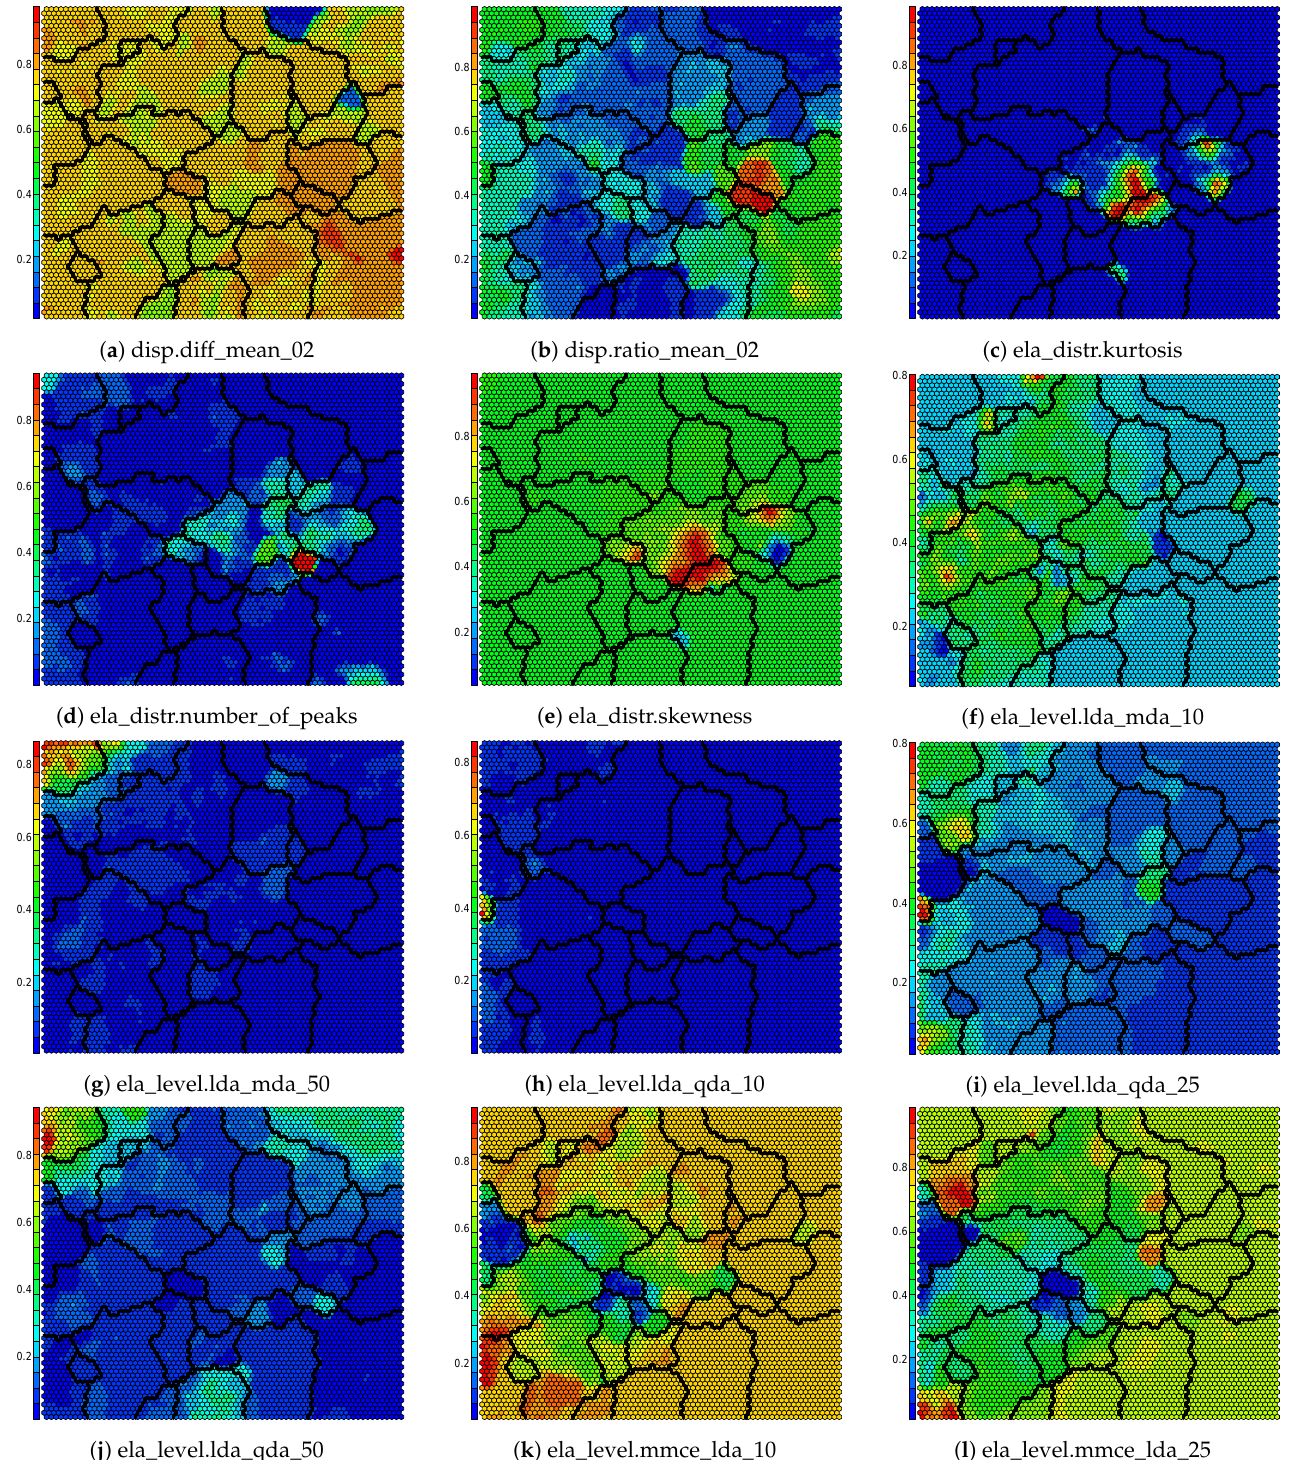
Figure A2. Normalized component maps from the clustered